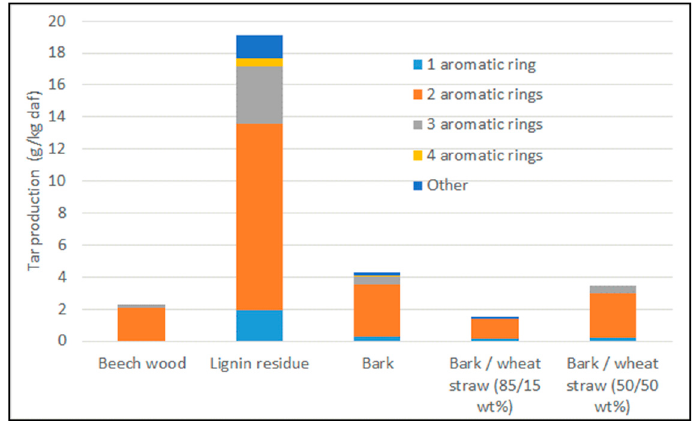
Figure 6. Condensable tar production (without BTX) for each feedstock.